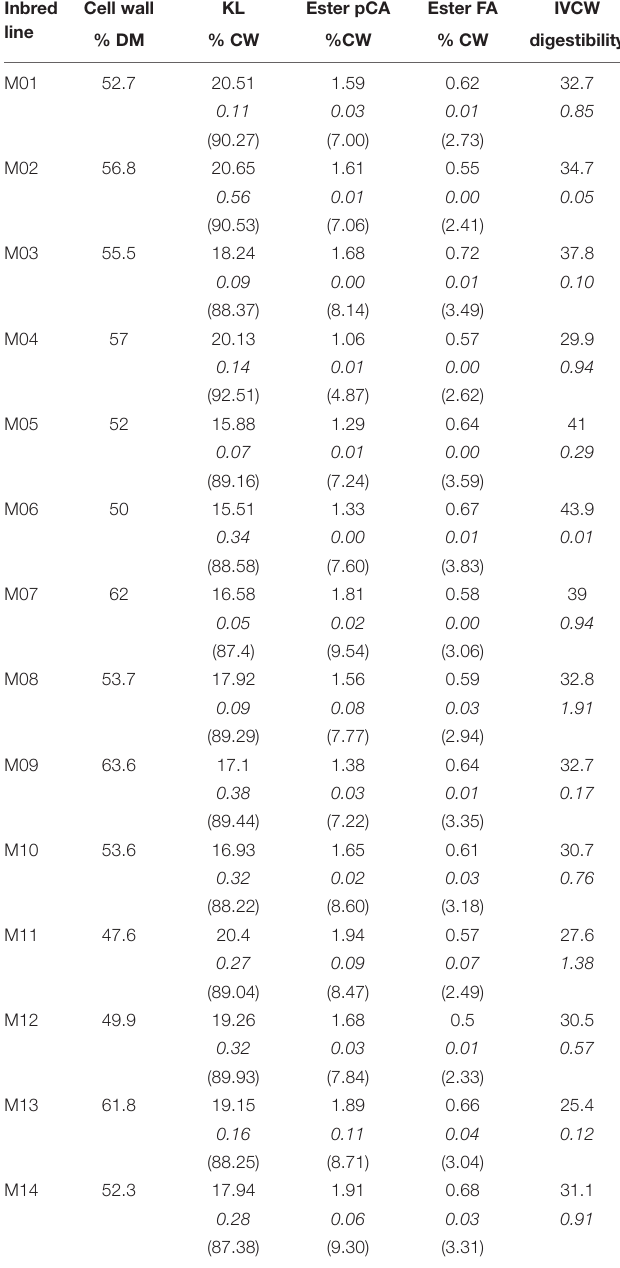
TABLE 2 | Mean values for stem cell wall contents, Klason lignin (KL), hydroxycinnamic acid – esterified p-coumaric acid (Ester pCA), esterified ferulic acid (Ester FA) – and cell wall digestibility (IVCW digestibility) for the 14 inbred lines. Inbred line